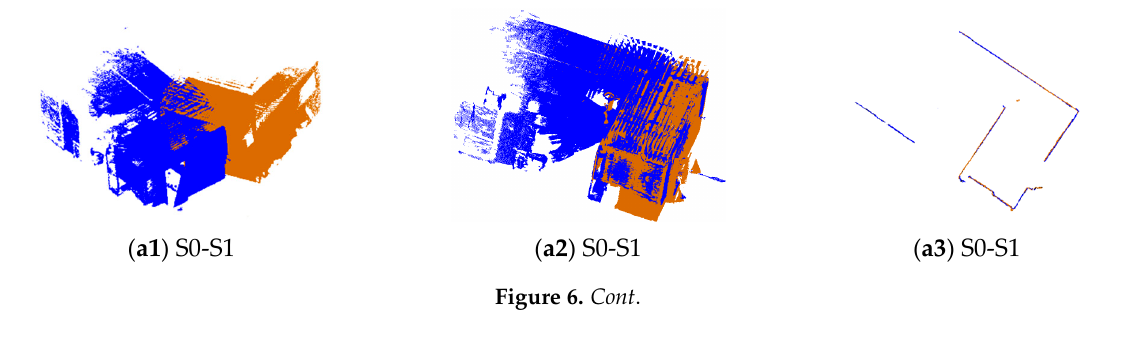
Figure 5. The registration results of 10 pairs of point clouds in dataset SR. The first column is the point clouds before registration, the second column is the point clouds after registration using the proposed method, and the third column is the horizontal section view of the point clouds after registration. The brown points are target points and the blue points are source points.